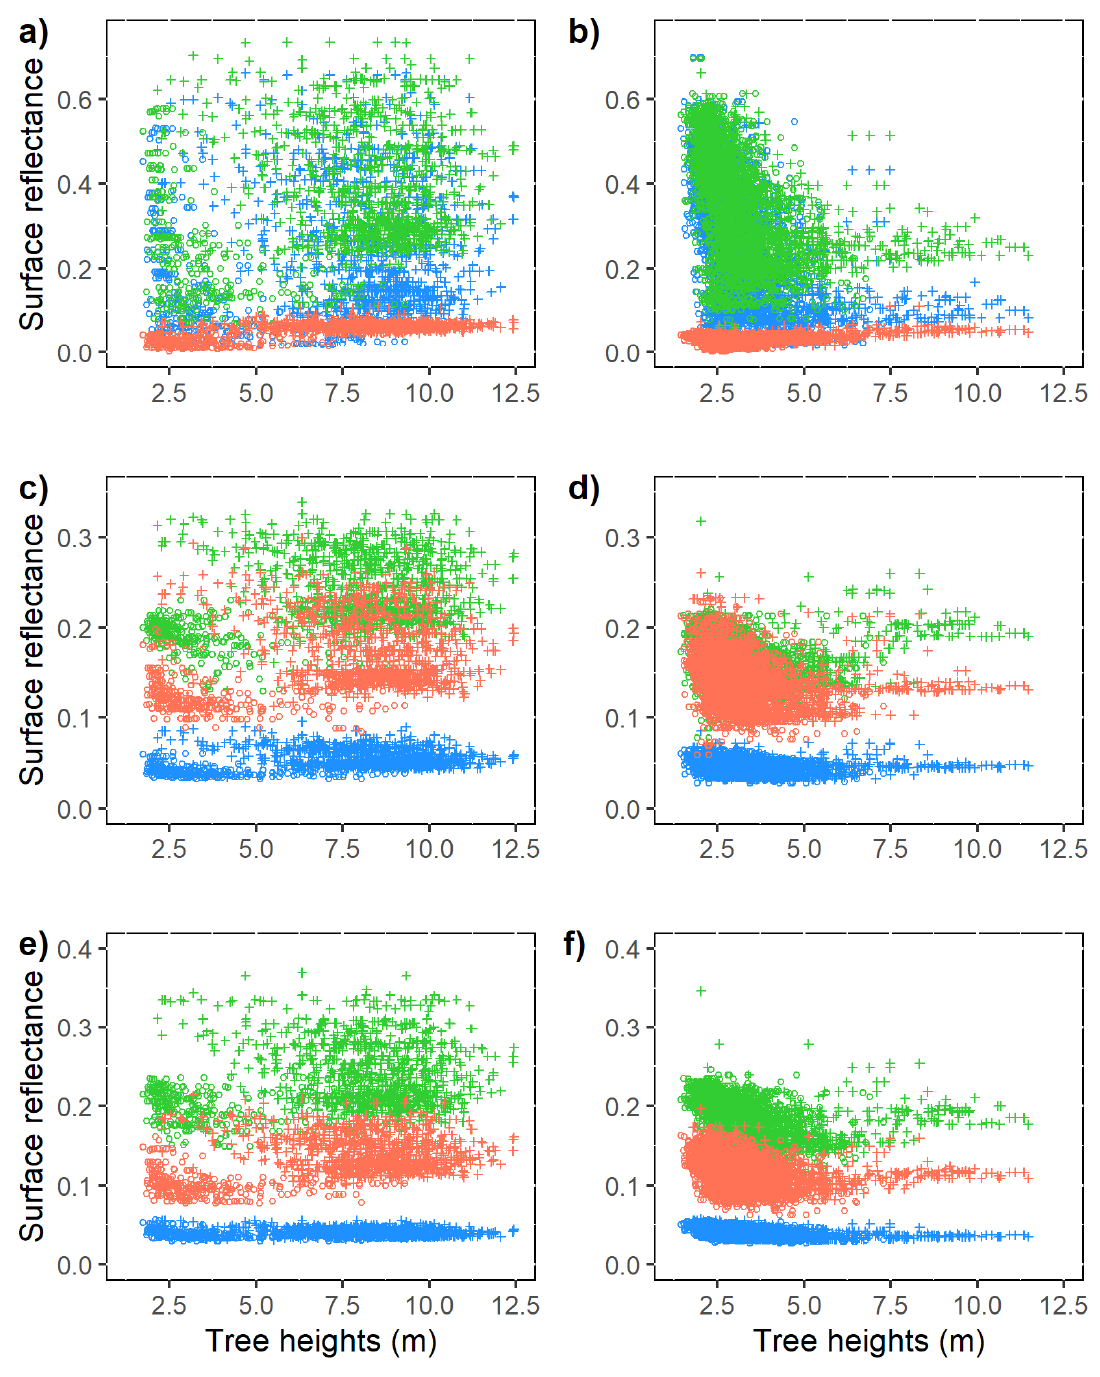
Figure 7. Relationships between surface reflectance (visible band in blue, near-infrared band in green, and shortwave infrared band in orange) and tree heights in March (upper panel), May (middle panel), and August (lower panel) 2014. Trees in the northern aspect are represented by an open circle, and in the southern aspect, by a cross symbol. Sub-plot ( a , c , e ) are for deciduous forests, while sub-plot ( b , d , f ) are for evergreen forests.